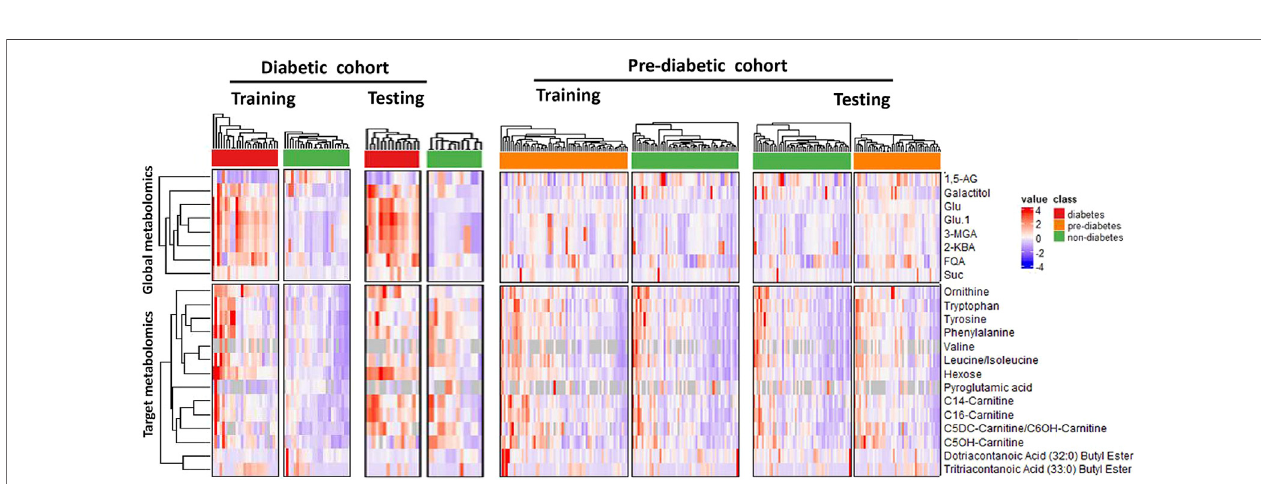
FIGURE 4 | Unsupervised clustering (heatmap analysis) of 22 classifying metabolites (8 from global metabolomics and 14 from targeted metabolomics) reveals distinctmetablicpatternsseparatingdiabetic,pre-diabeticsamplesfromhealthycontrols.Abbreviationsareasfollows:1,5-AG,1,5-anhydroglucitol;FQA,Feruloylquinic acid; Glu, Glucose; 3-MGA, 3-methylglutaconic acid; 2-KBA, 2-ketobutyric acid and Suc,